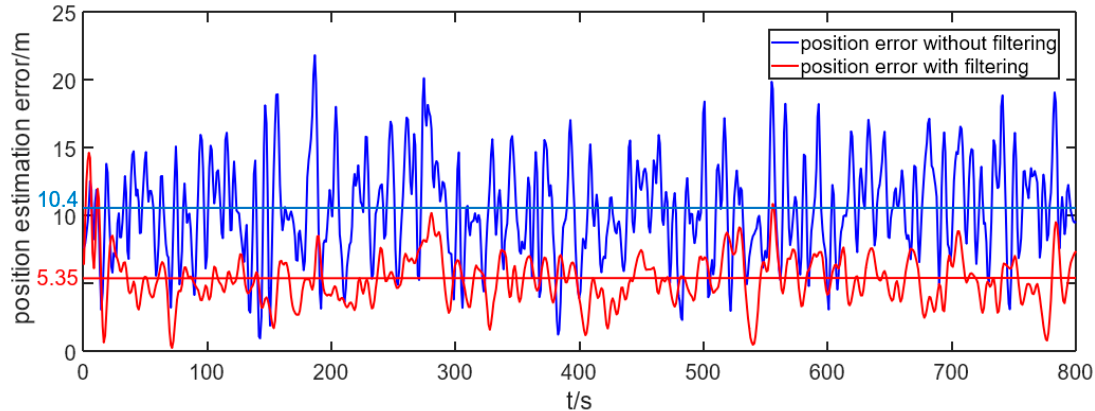
Figure 13. Position estimation error versus time.